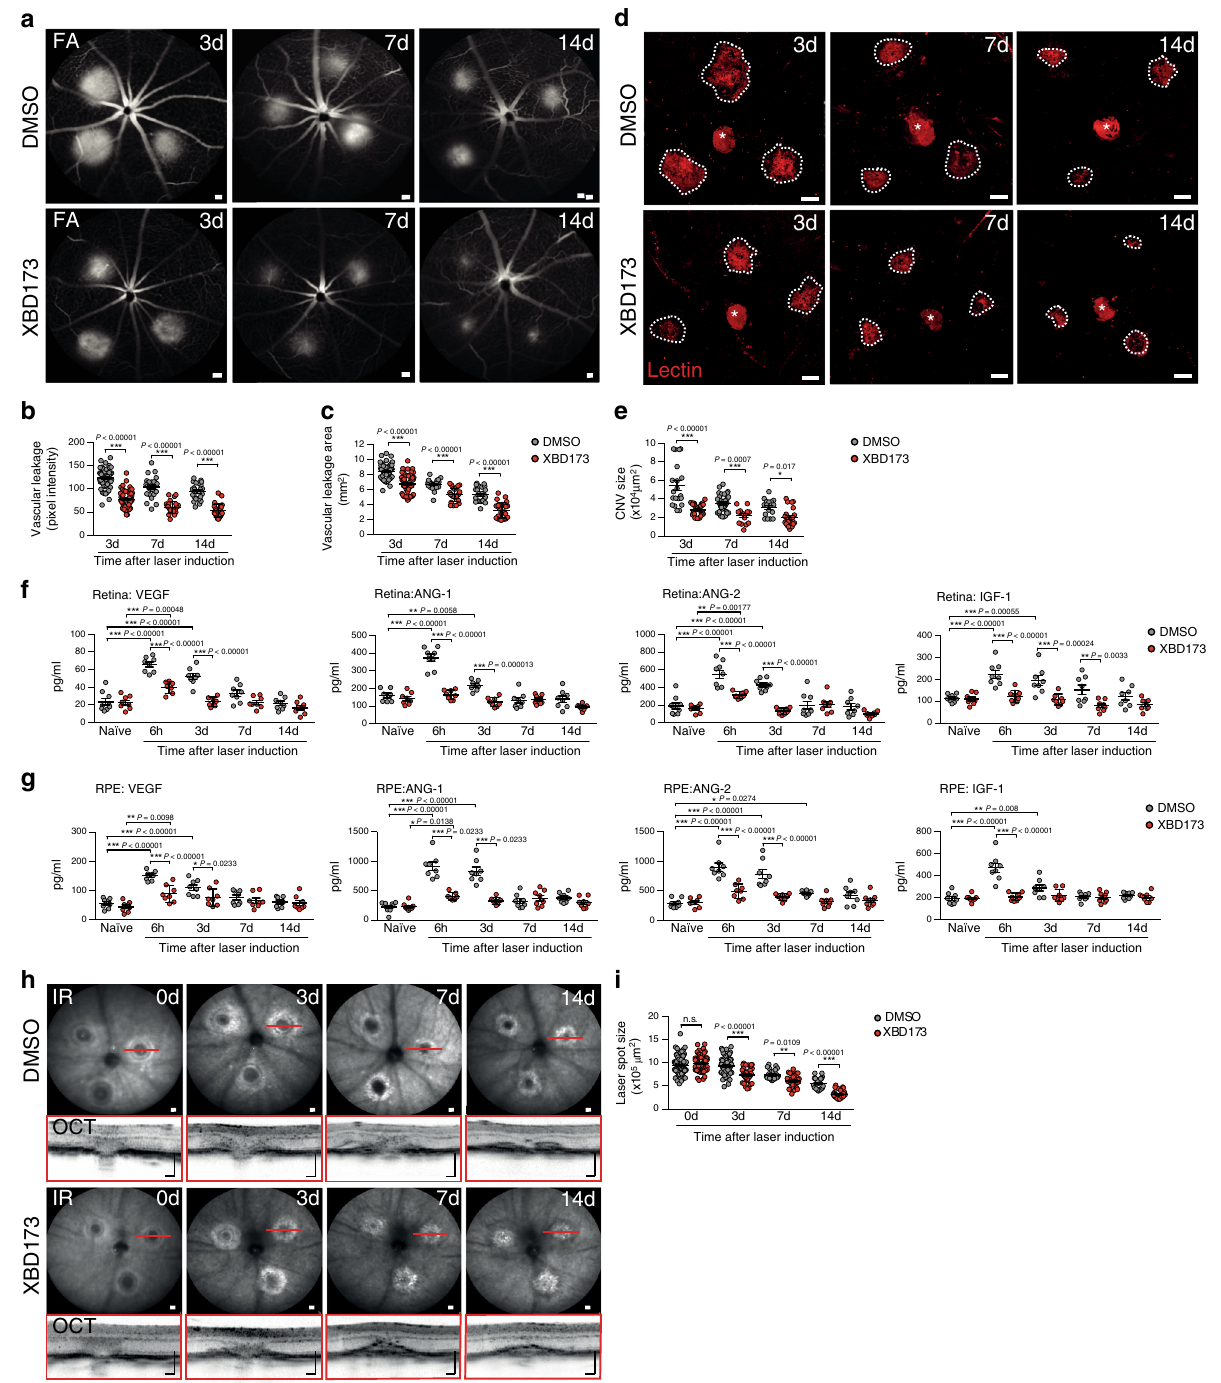
Fig. 2 XBD173 inhibits laser-induced vascular leakage and pathological choroidal neovascularization (CNV) in mice. a Representative late phase fundus fl uorescein angiography (FFA) images at indicated time points post laser injury. Scale bar: 200 µ m. b Quanti fi cation of vascular leakage intensity after laser-induced CNV. 3 d n = 56; 7 d, 14 d n = 25 eyes from individual mice. c Quanti fi cation of vascular leakage area after laser-induced CNV. 3 d n = 56; 7 d, 14 d n = 25 eyes from individual mice. d Representative laser-induced CNV stained with isolectin B4 in RPE/choroidal fl at mounts. Scale bar: 100 µ m; FA fl uorescein angiography. e Quanti fi cation of laser-induced CNV area in RPE/choroidal fl at mounts. DMSO/XBD173 3 d n = 18/34; 7 d n = 38/17; 14 d n = 17/23 RPE/choroids from individual mice. f Pro-angiogenic growth factor levels in retinas of naïve and lasered mice at indicated time points. n = 8 eyes from individual mice. g Pro-angiogenic growth factor levels in RPE/choroids of naïve and lasered mice at indicated time points. n = 8 eyes from individual mice. h Representative infrared (IR) fundus images at indicated time points post laser injury. Lower panel shows OCT scan from one laser spot marked by a red line. Scale bar: 200 µ m. I Quanti fi cation of laser spot size. DMSO/XBD173 0 d n = 106/71; 3 d n = 72/42; 7 d, 14 d n = 26 eyes from individual mice. Data show mean ± SEM and a linear mixed model was used for statistical analyses; * P < 0.05; ** P < 0.01; and *** P ≤ 0.001. n.s., not signi fi cant. Source data are provided as a Source Data fi